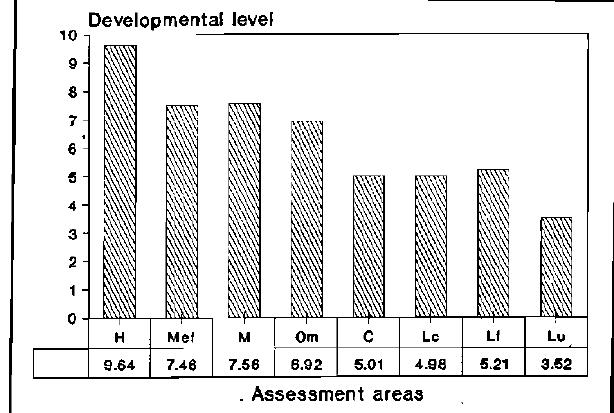
Figure II: Average developmental levels of subjects, N=50 Key: H= Hearing abilities; Mef= Middle ear functioning; M= Motor skills; Om= Oral-motor skills; C= Precur- sors of cognition; Lc= Precursors of language con- tent; Lf= Precursors of language form; Lu= Precur- sors of language use